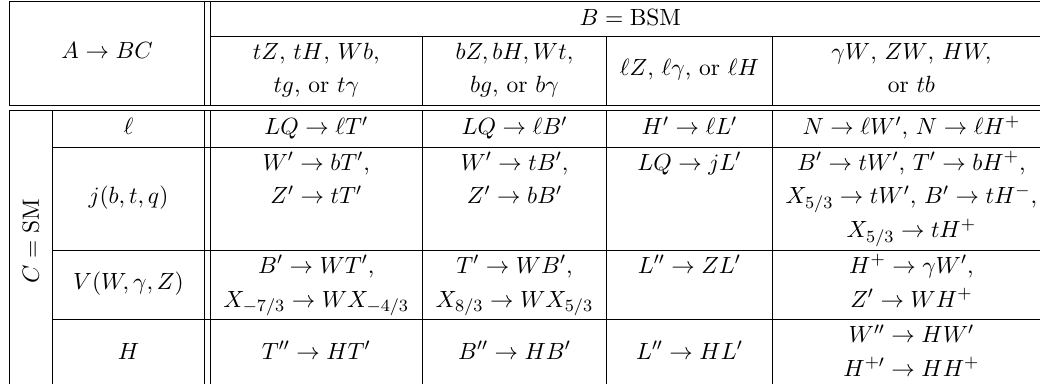
Table 3 . Example (Group III in table 1) for A ! BC , where A and B are BSM particles and C is a SM particle. The B decays to two di(cid:11)erent SM particles are considered. Here the LQ is a leptoquark carrying both baryon and lepton numbers, and the N is a right-handed heavy neutrino. Exotic vector-like quarks with electric charges (cid:0) 7 = 3, (cid:0) 4 = 3, 5 = 3, and 8 = 3 are denoted as X , X , X , and X respectively. The H + and H (cid:0) (cid:0) 7 = 3 (cid:0) 4 = 3 5 = 3 8 = 3 are new charged scalar particles.